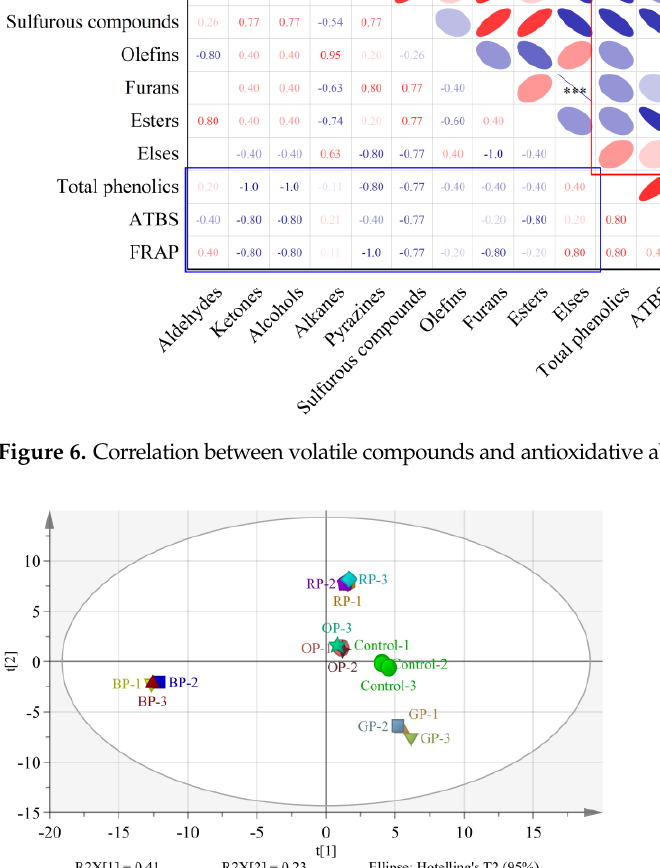
Figure 7. Score plot of PCA of volatile compounds of control extrusion products and those with spices.